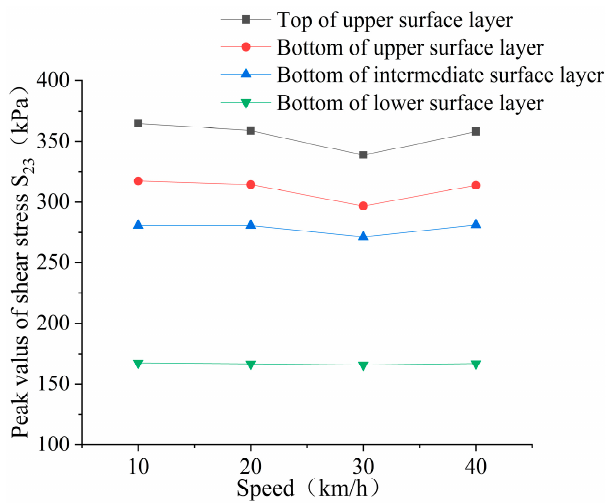
Figure 15. Variation in peak value of shear stress with vehicle speed.